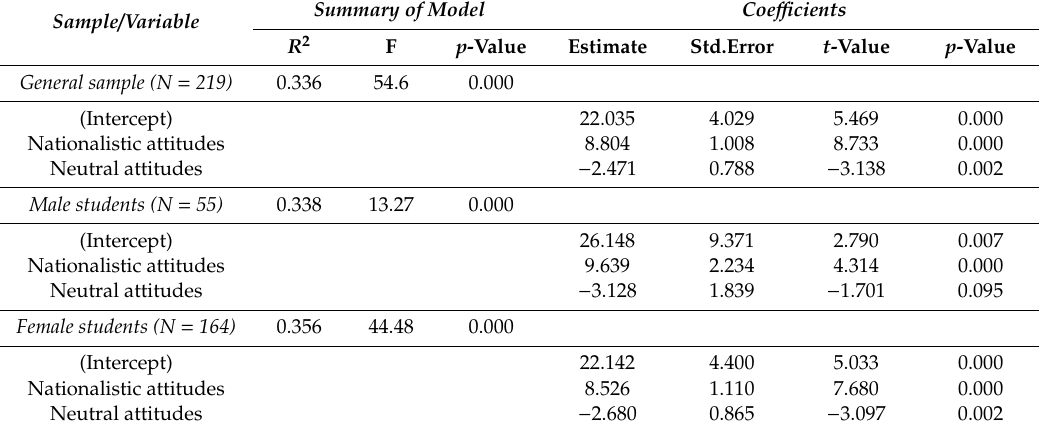
Table 4. Best predictor regression models for Absolutization subscale of